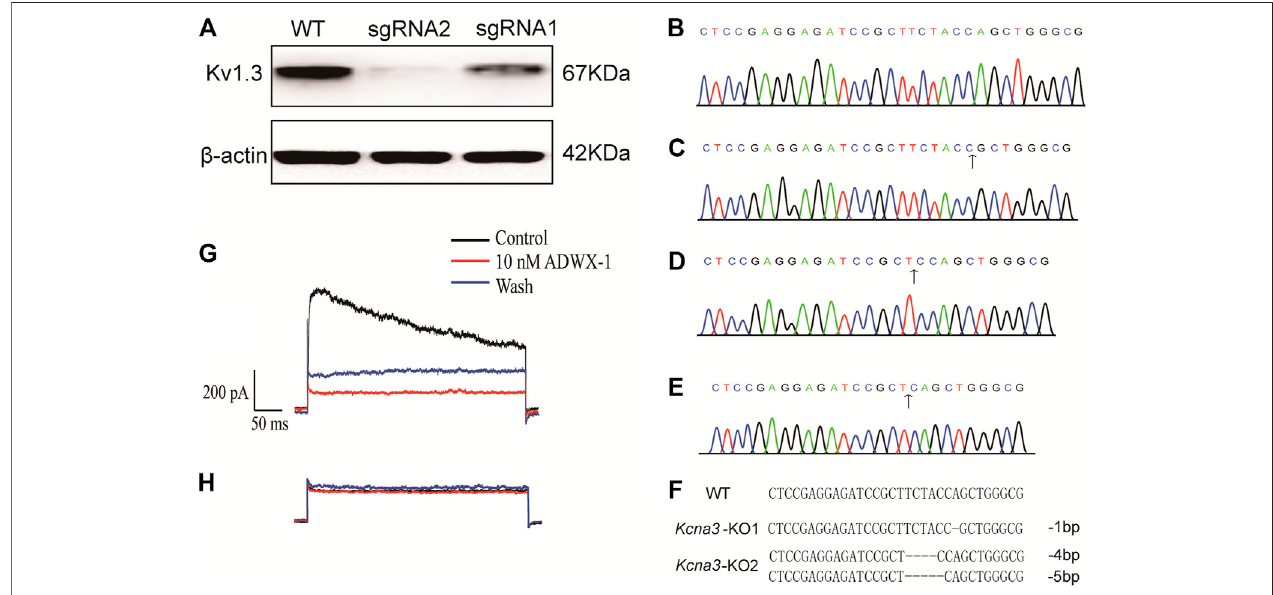
FIGURE1| Con fi rmation ofKv1.3KOinJurkat Tcells. (A) Western BlotforK V 1.3expression inwildtype andKv1.3KOcells ( n (cid:2) 3); (B) Sequencing oftarget gene in wild type Jurkat T cells; (C) Sequencing of target gene in KO-1 colony which has one bp nucleotide loss compared with wild type, the black arrow indicates the start point ofCRISPR/Cas9 editing; (D,E) KO-2 colony has four and fi ve bp nucleotide loss respectively, the black arrow indicates the start point ofCRISPR/Cas9 editing; (F) Alignment of the wild type, KO-1 and KO-2 Jurkat T cell colonies; (G) Membrane current of a wild type Jurkat T cell was irreversibly inhibited by 10 nM ADWX-1 ( n (cid:2) 3); (H) Membrane current of a Kv1.3 knockout Jurkat T cell was nearly abolished and the remaining residual current was not further inhibited by ADWX-1 ( n (cid:2) 3).